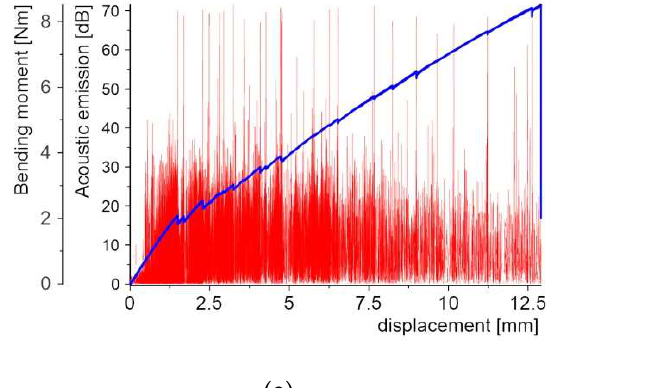
( c ) Figure 9. Bending moment and AE vs. displacement diagrams for 3 specimens with the quartz sand PL: ( a ) sample 2_1; ( b ) sample 2_2; and ( c ) sample 2_3. For samples with the Al 2 O 3 powder PL (Figure 10), the first force drop appears at the bending moment equal to 2.57–2.91 Nm, which corresponds to the displacement of 2.36 mm–2.64 mm. The maximum values of the AE signals at 70 dB are related to the visible bending moment drops. There are a sparse number of signals at the tens of the dB level compared to the quartz powder.